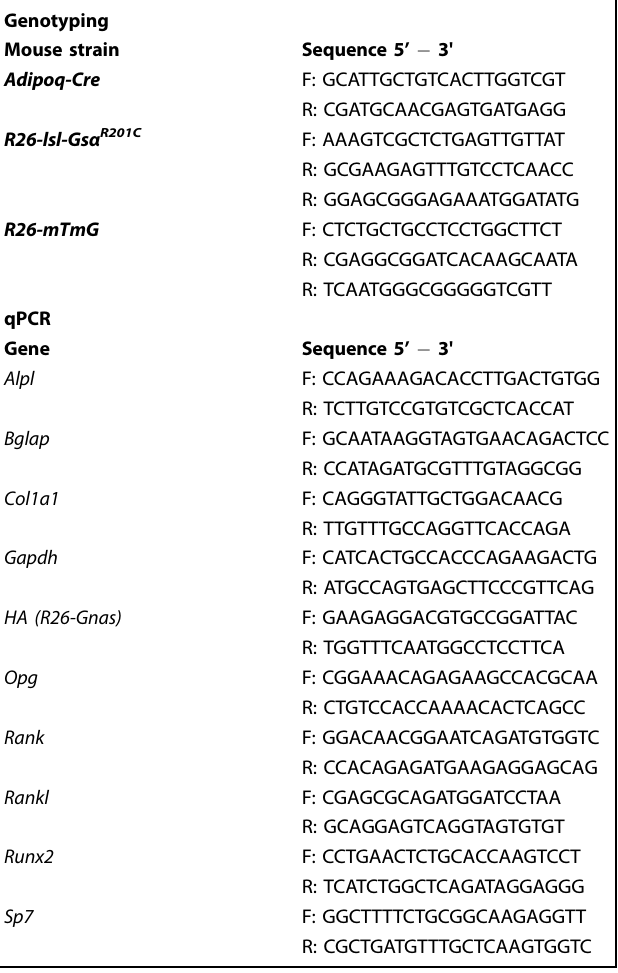
staining with Hematoxylin-Eosin (H&E) or with Sirius red to visualize collagen fi bers, for Tartrate-Resistant-Acid-Phosphatase (TRAP) histochemistry to highlight cells of the osteoclastic lineage and for histomorphometry. MMA embedding was performed on undecalci fi ed bone segments. After dissection, bone samples were fi xed in 4%